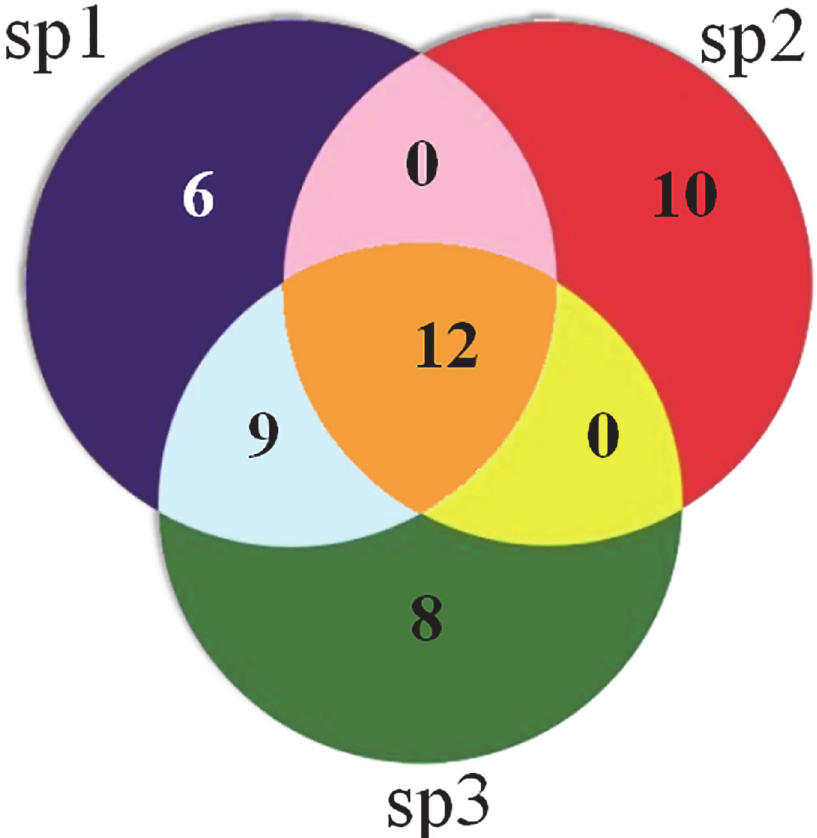
Fig 4. The SNPs composition output chart of three HA sequences from three IFV subpopulations. Each circle represents the number of SNPs of VIROAF1 (sp1), VIROAF2 (sp2) and VIROAF6 (sp3) for the HA fragment; universal SNPs; unique SNPs; and likely common